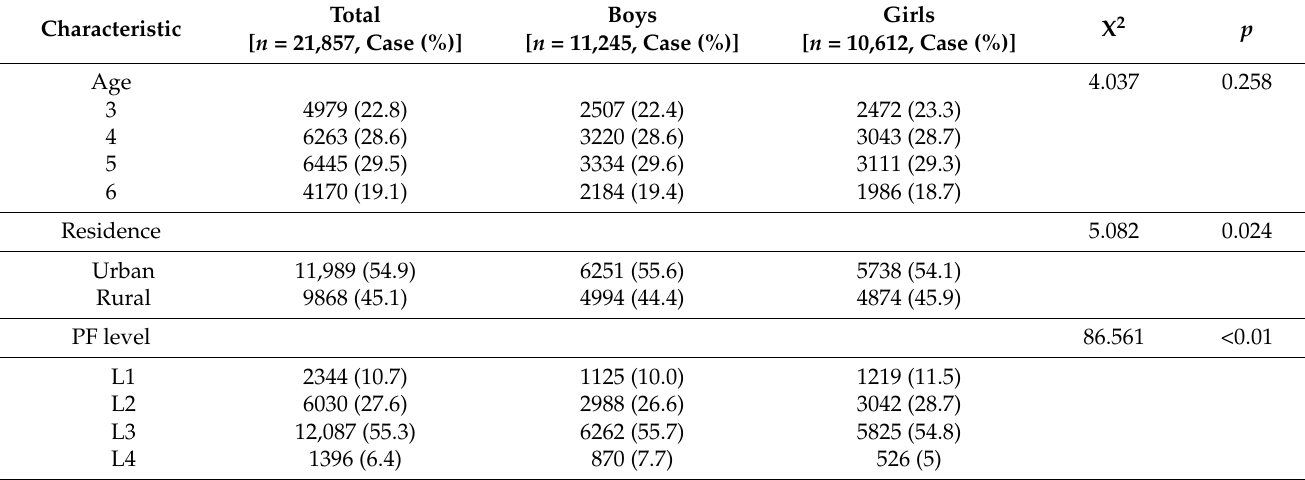
Table 3. Characterization of PF level of